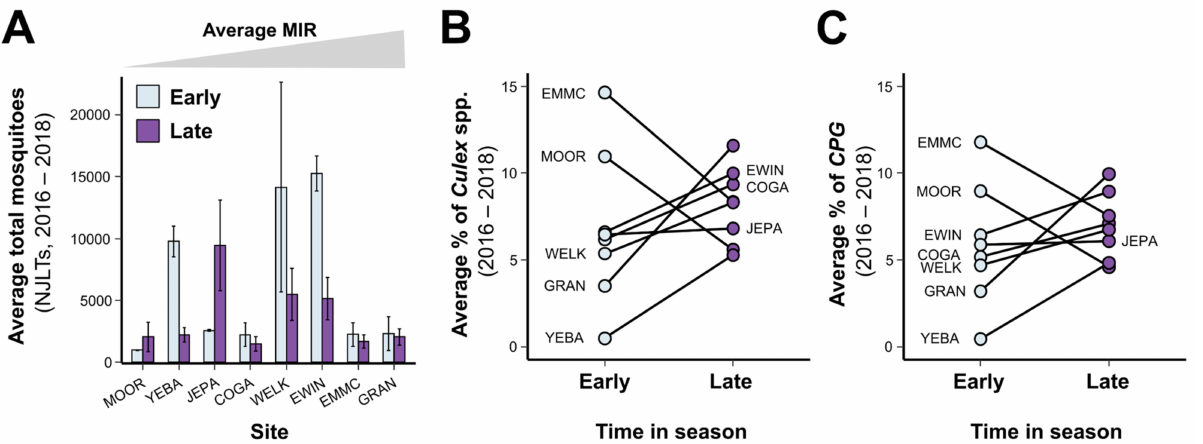
Figure 2. Mosquito communities vary across study sites and temporally during the season. Total mosquito numbers collected from NJLTs were averaged from 2016–2018 and displayed by site in order of increasing mosquito MIR ( A ). Data are displayed as the average ± SEM for the early (weeks 20–31) and late (weeks 31–40) times of the year. The average percentage of Culex spp. ( B ) or Culex pipiens group (CPG) mosquitoes ( C ) collected at each site compared with the total number of mosquitoes are displayed for both the early and late seasons. Connecting lines are to aid in the visualization of the data between time